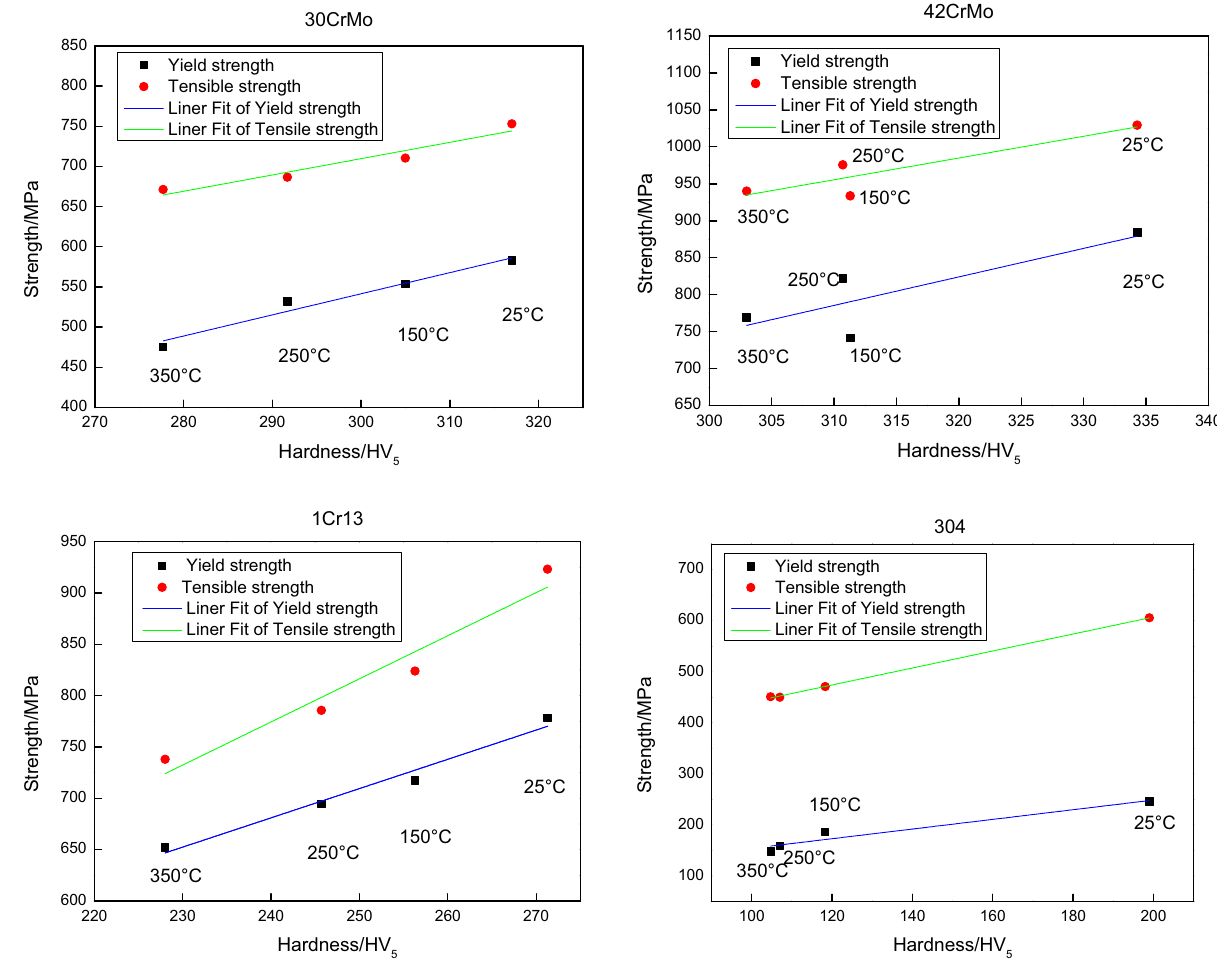
Figure 11: Relationship between strength ( yield strength and tensile strength ) and microhardness at 25, 150, 250, and